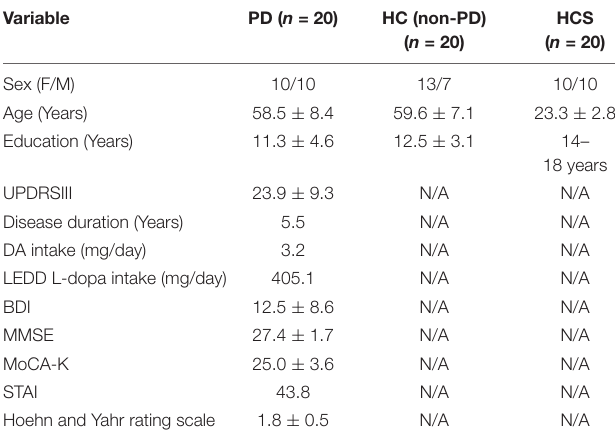
TABLE 1 | Clinical